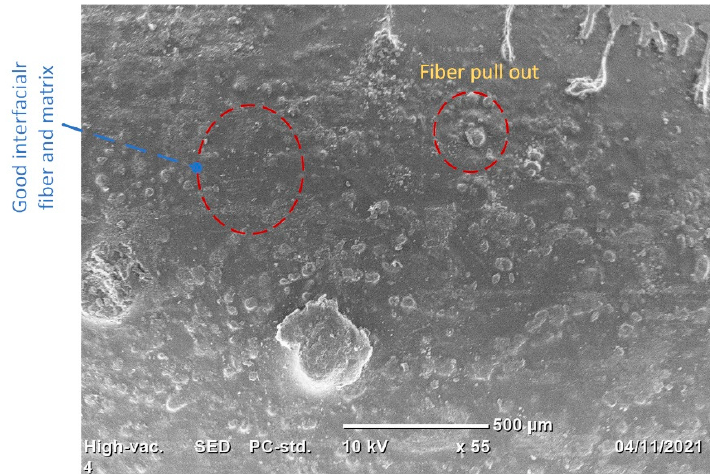
Figure 9. SEM image of 0/100 of enset–sisal hybrid composite.